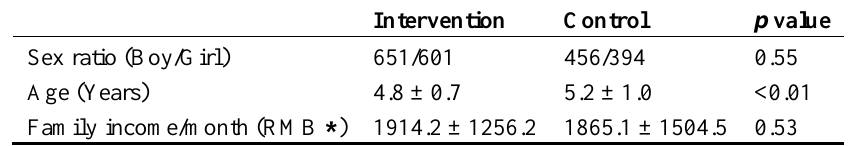
Table 2. Characteristics of the intervention and control groups in baseline (mean ±